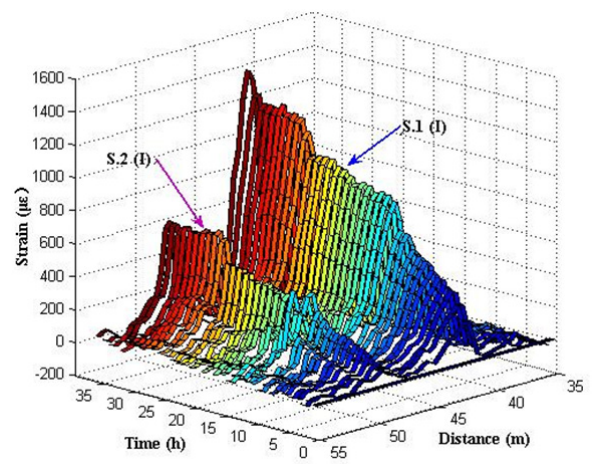
Figure 13. The expansion strain results of S.1 (I) and S.2